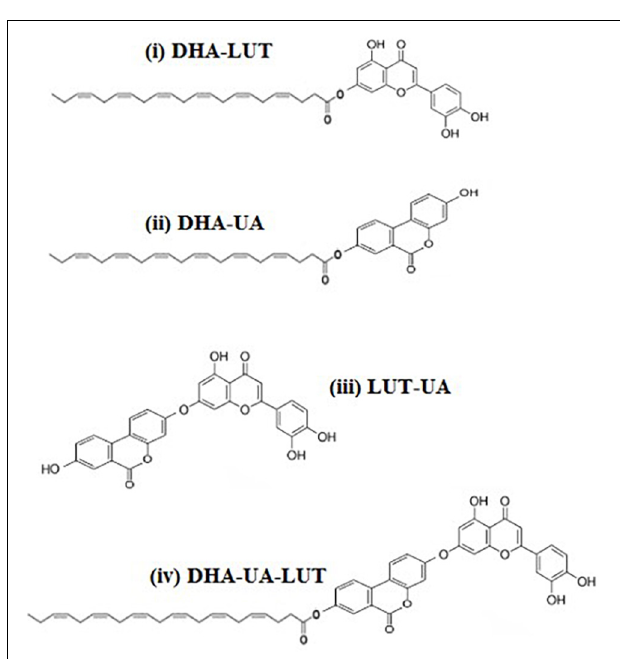
FIGURE 7 | Predicted chemical conjugations for the three-compound combination, D 5 L 5 U 5 . For the DHA-LUT-UA combination, four chemical conjugations are predicted as (i) DHA-LUT (ii) DHA-UA (iii) LUT-UA (iv)